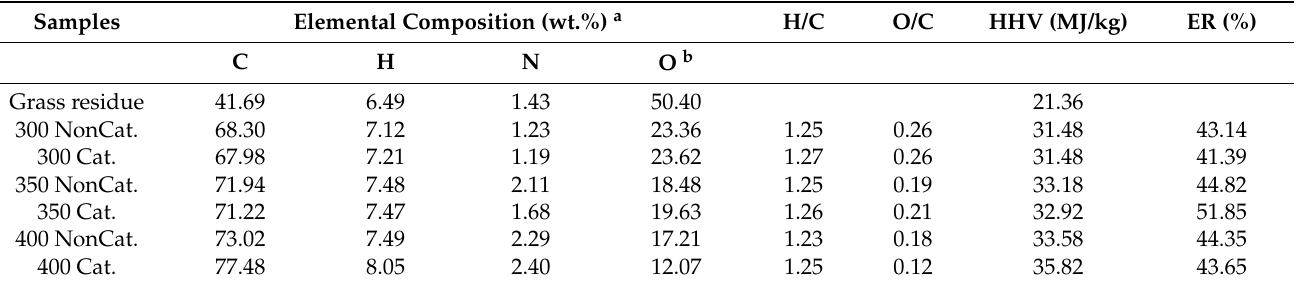
Table 2. Elemental composition of